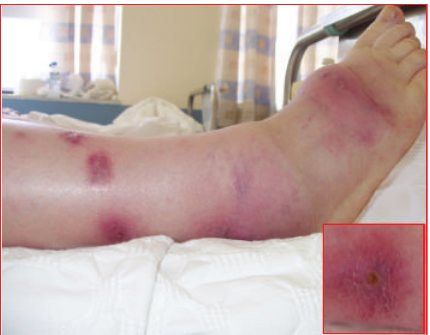
Figure 2: Ziehl-Neelsen staining of pus obtained from a draining lesion reveals multiple acid-fast bacilli.